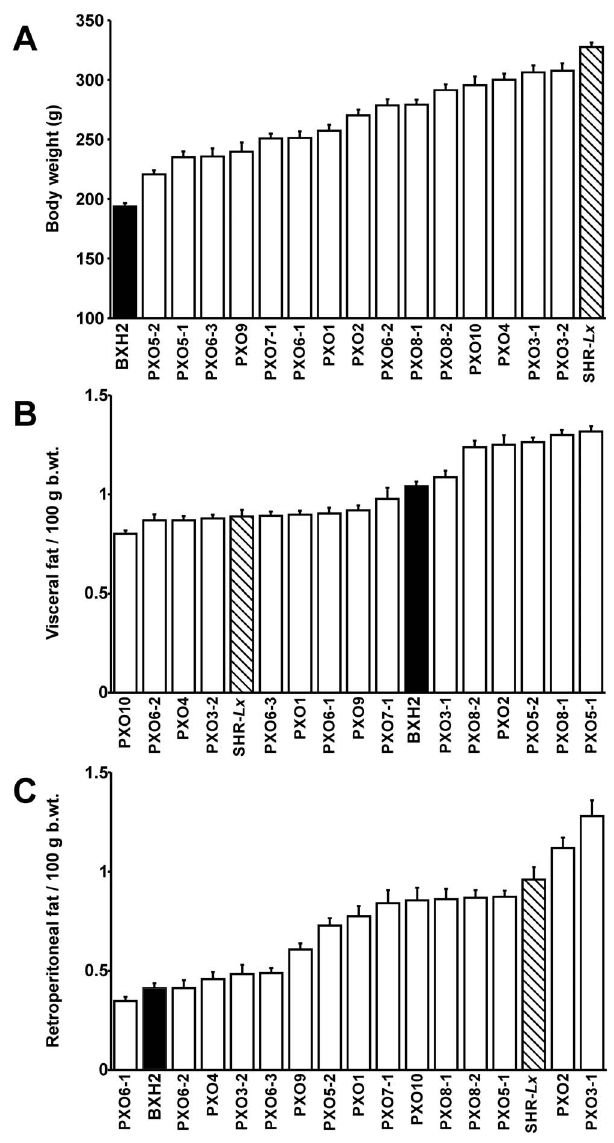
Figure 1. Strain distribution pattern for body weight (b.wt., panel A); visceral fat weight/100 g b.wt. (panel B) and retroperitoneal fat weight/100 g b.wt. (panel C), ordered by their means. Values are shown as means 6 S.E.M. for adult male rats of progenitor strains BXH2 (n=18, black bar), SHR- Lx (n=13, striped bar) and all 15 PXO recombinant inbred strains (n=8–13/strain, white bars).